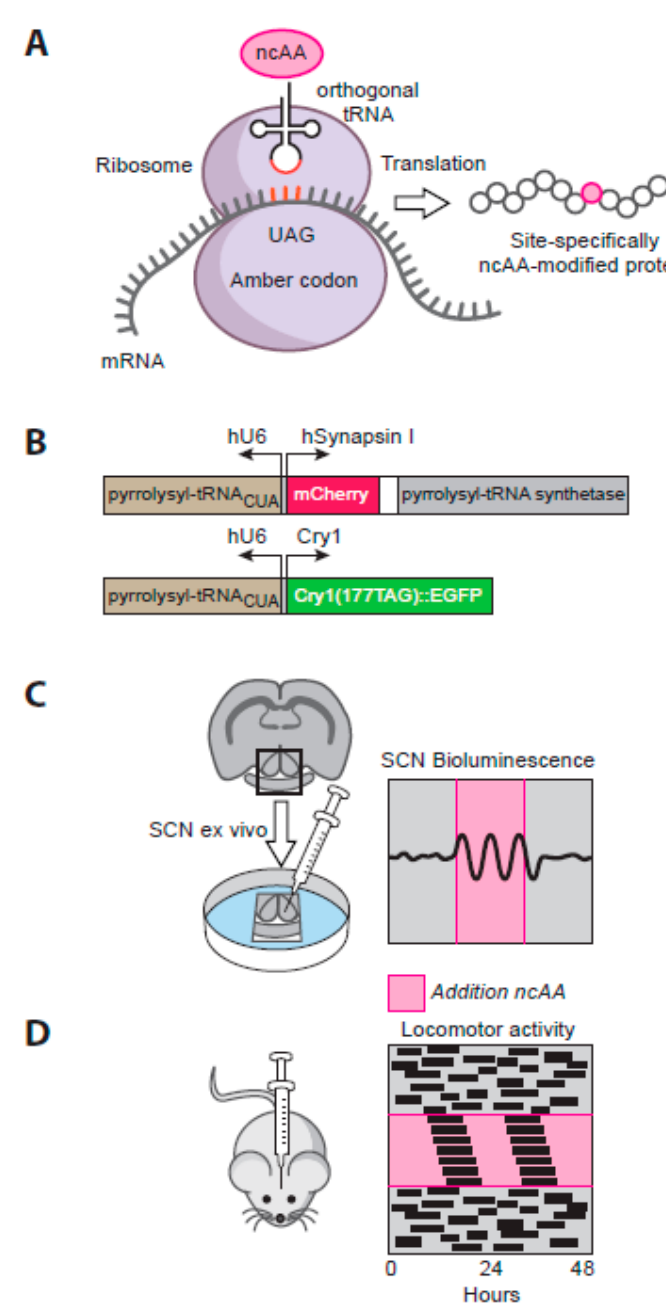
Figure 3. Translational switching: a versatile tool for reconstituting and exploring the circadian clock. ( A ) Schematic view of the site-specific incorporation of a non-canonical amino acid (ncAA, pink shade) during translation of a protein by using a novel aminoacyl transfer RNA (tRNA) (charged by a novel tRNA synthetase) that recognises the amber stop codon, thereby allowing translational read-through. (B ) Constructs encoding the orthogonal tRNA and tRNA synthetase, alongside the amber-sensitive Cry1::EGFP, both delivered to SCN cells by AAV vectors. ( C ) In arrhythmic Cry-null SCN slices, pre-transfected with the two AAV vectors, delivery of ncAA (pink shade) initiates a circadian rhythm (reported as Per2-driven bioluminescence), which is lost immediately on withdrawal of ncAA. ( D ) In arrhythmic Cry-null mice, pre-transfected with the two AAV vectors directed at the SCN, delivery of ncAA (pink shade) in drinking water initiates a circadian behavioural rhythm, which is lost immediately on withdrawal of ncAA.